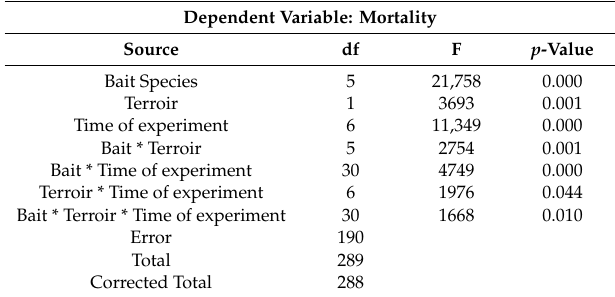
Table 2. Three-way ANOVA post hoc bonferroni test with mortality as variable.